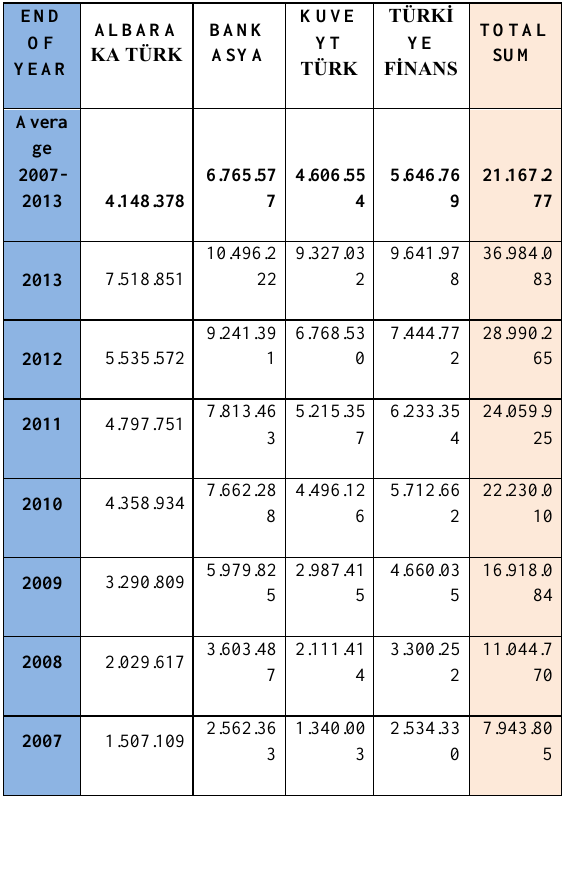
Table-6/a: Collected Turkish Currency Funds in Participation Banks, 2007-2013